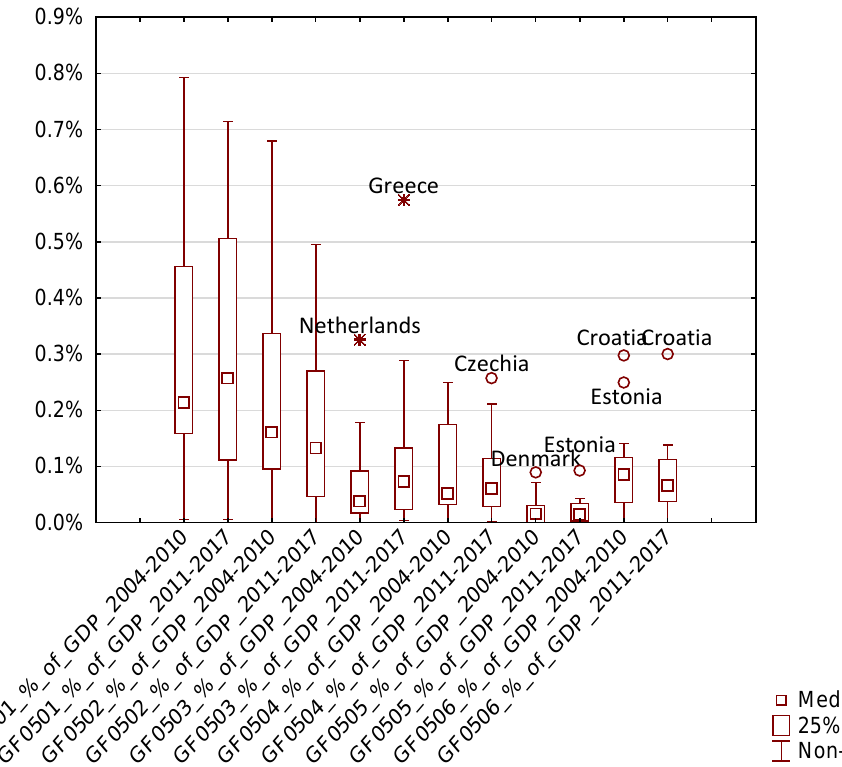
Figure 4. Empirical distribution characteristics of public expenditure on various aspects of environmental protection (as a percentage of the GDP) in the EU member states in 2004-2010 and 2011-2017. Source: author’s own study carried out using the ‘STATISTICA’